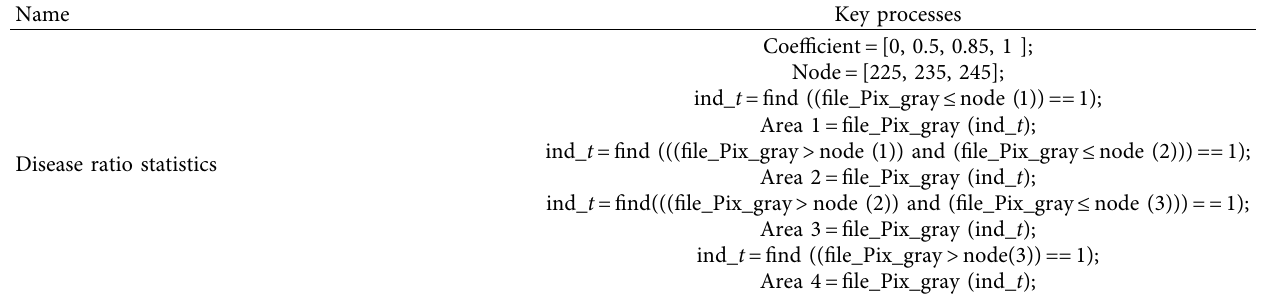
Table 7: Key processes in image disease ratio statistics.